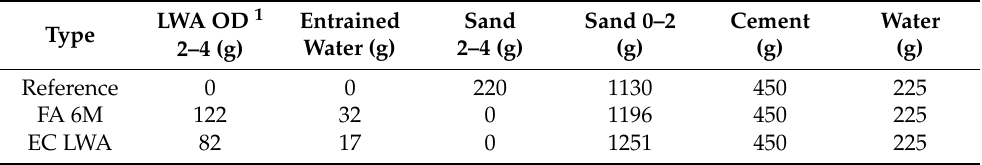
Table 3. Mix design of three mortar